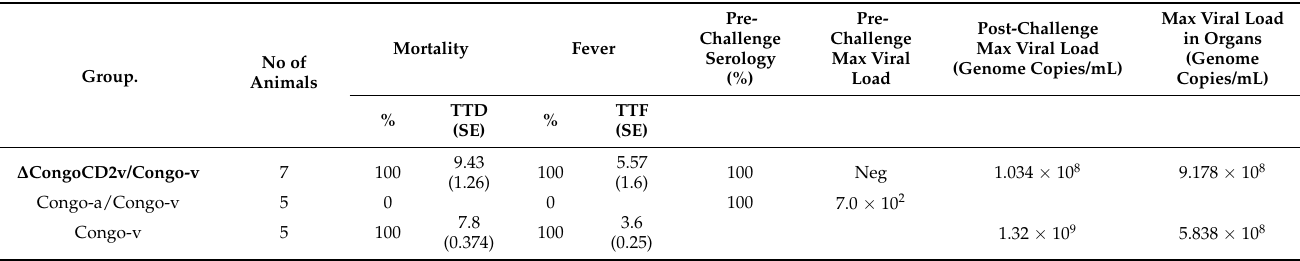
Table 1. Pig survival, fever, and maximum viral load following infection with Congo-a and ∆ CongoCD2v and challenge with 10 3 HAD50 ASFV Congo-v.